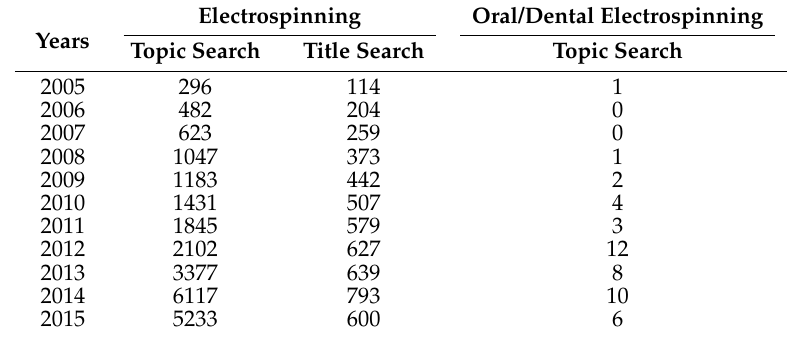
Table 1. Number of peer reviewed scientific papers published on “electrospinning” in recent years.